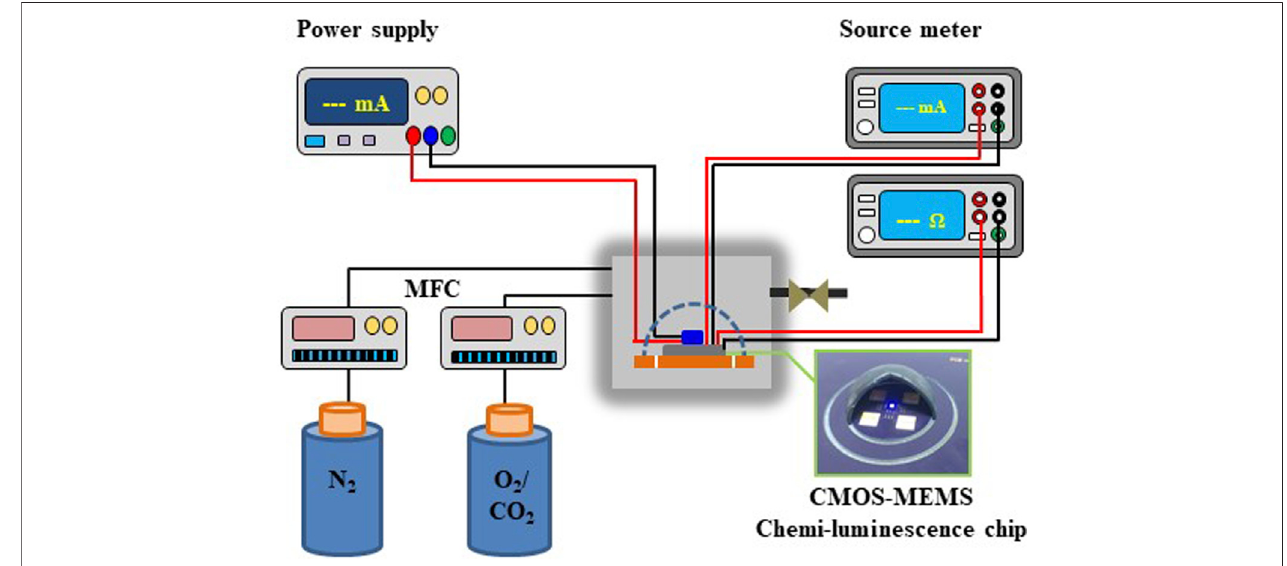
FIGURE 9 | Experimental setup for gas sensing tests.